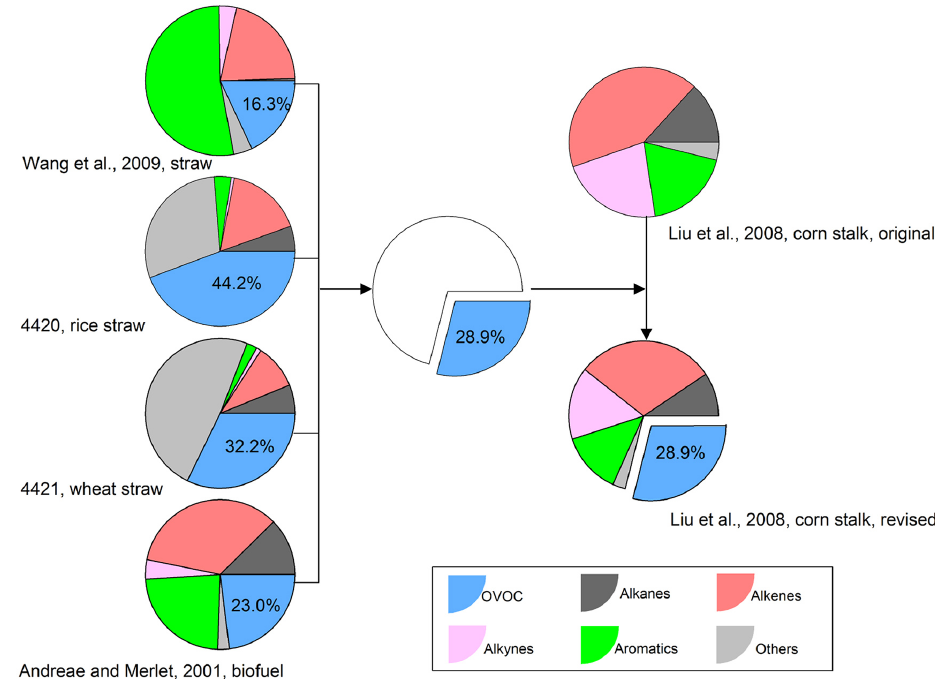
Figure 3. Inclusion of OVOC fraction for incomplete crop residue combustion profiles. The values 4420 and 4421 are the “P_NUMBER”s of profiles taken from the SPECIATE database developed by the US